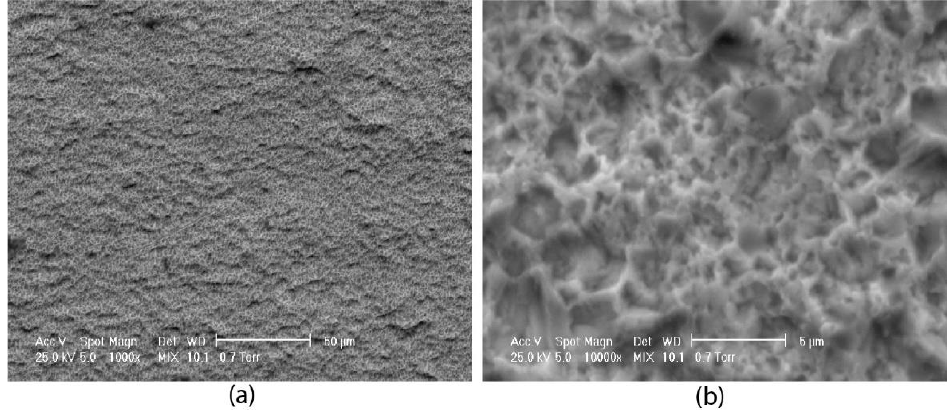
Figure 13. SEM morphology of the non-equimolar CoCrFeMnNi thin film, sample 2 (corroded): ( a ) ×1000; ( b ) ×10,000.